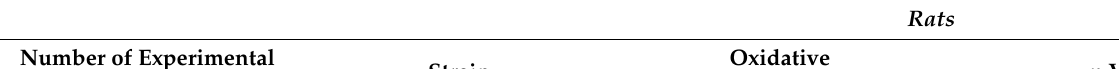
Year of Publication